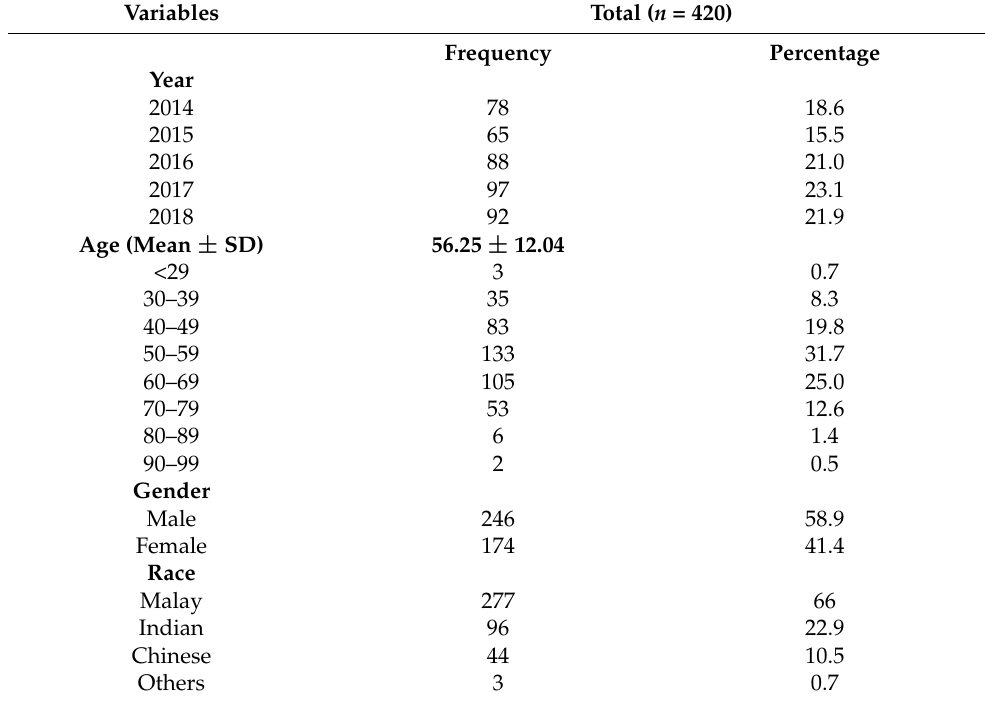
Table 1. Distribution of patients by socio-demographic characteristics.